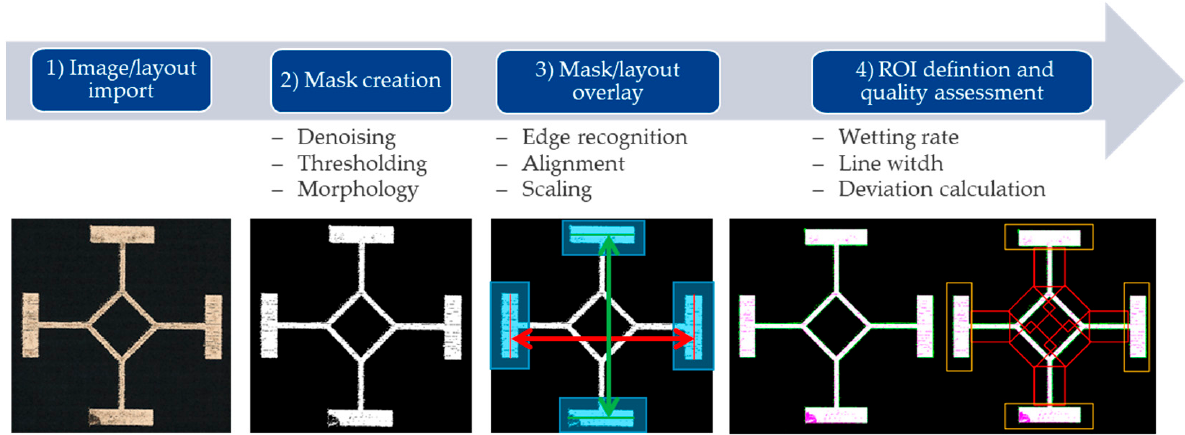
Figure 4. Analyzing sequence within the image analysis tool comprising the steps ( 1 ) image and layout import, ( 2 ) mask creation (Section 2.2.1), ( 3 ) overlay of mask and layout (Section 2.2.2) and ( 4 ) the definition of the region of interest and final quality assessment (Section